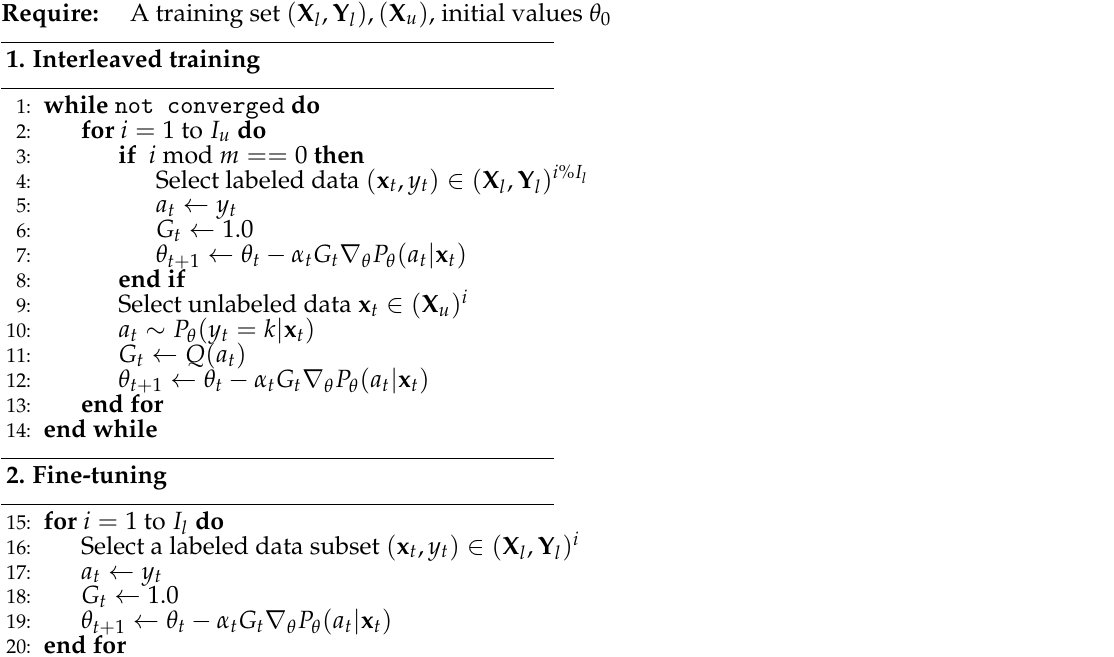
Algorithm 1 Proposed learning